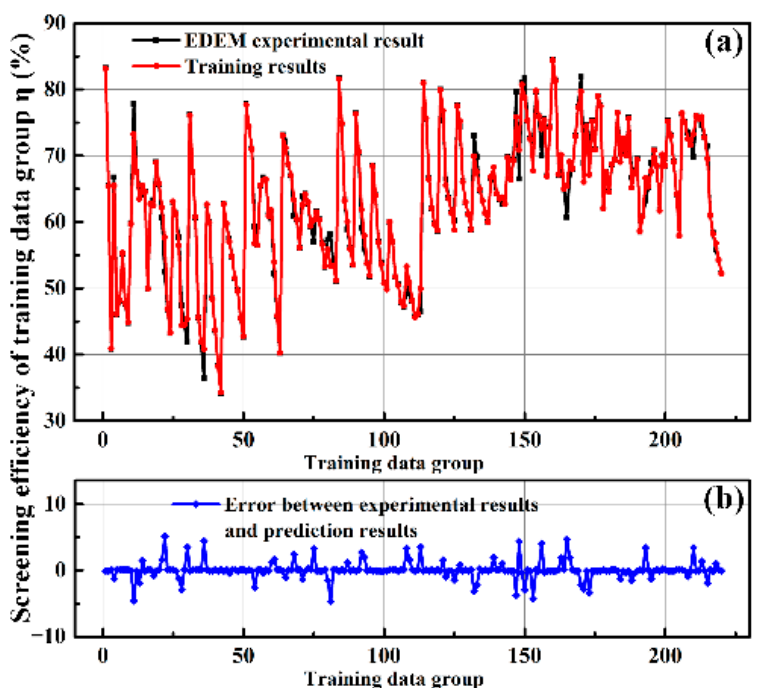
Figure 12. Comparison of screening e ffi ciency between the training and experiment. ( a ) training results, and ( b ) error results.